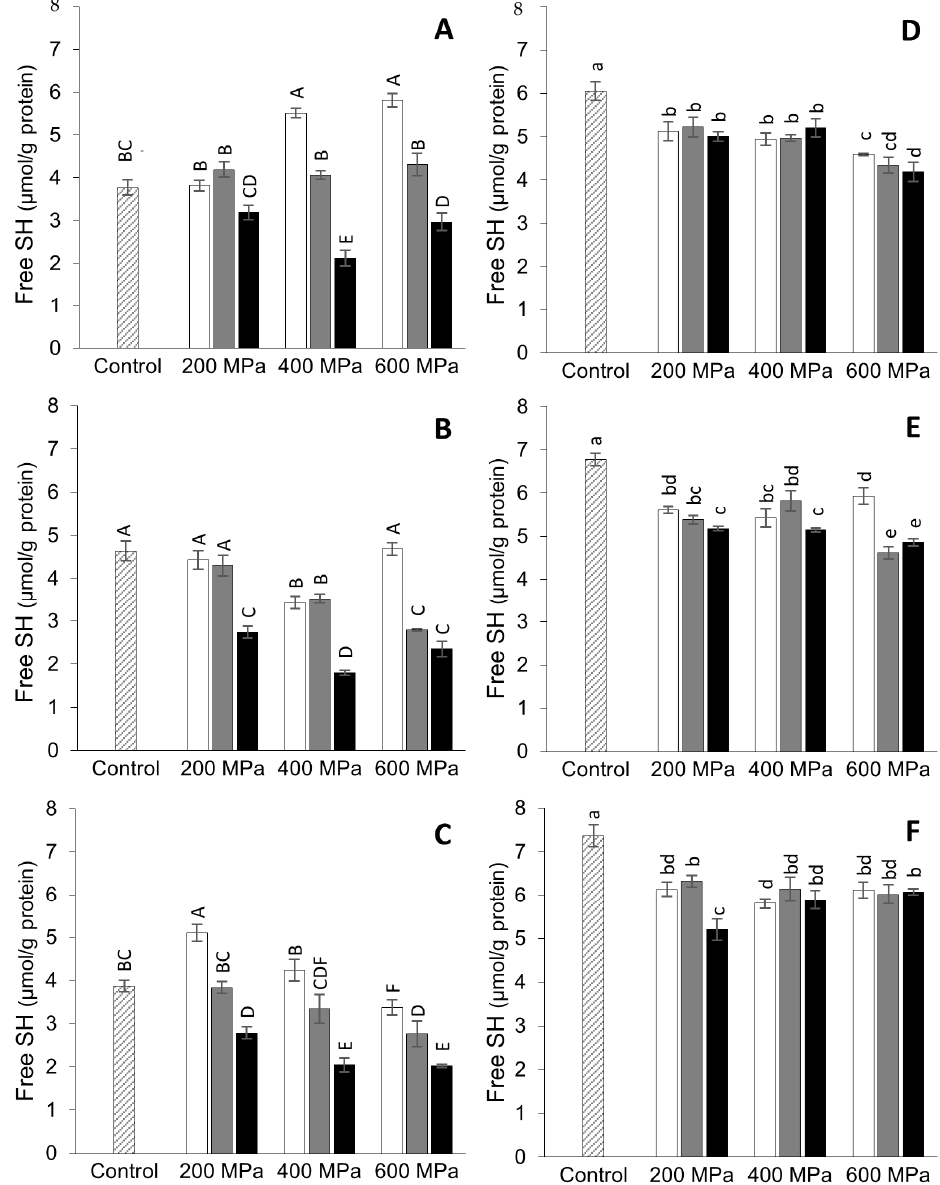
Figure 2. Effects of high-pressure processing, 200, 400 and 600 MPa for 5, 10 and 15 min on the content of free sulfhydryl groups of pea (( A )—pH 6, ( B )—pH 7, ( C )—pH 8) and soy (( D )—pH 6, ( E )—pH 7, ( F )—pH 8) protein isolates at different pH values. The columns with diagonal stripes represent control samples (0.1 MPa). Blank, gray and black filled columns denote 5-, 10- and 15-min processing times, respectively. Different letters indicate significant differences ( p < 0.05) between samples represented in each figure.